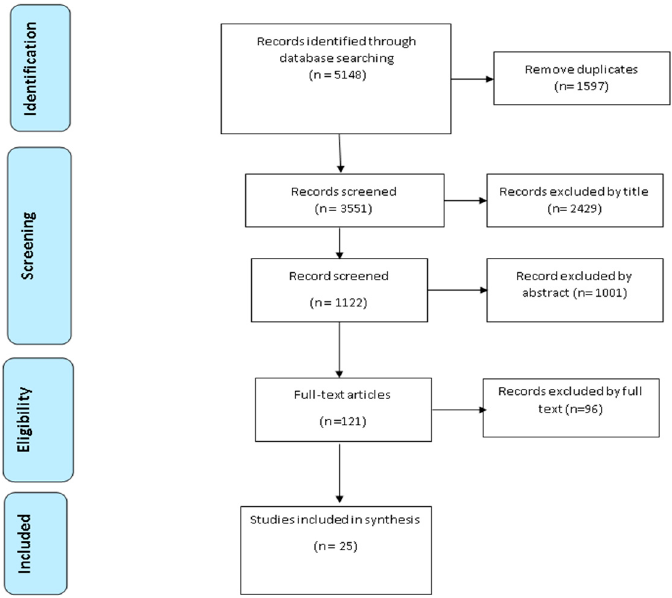
Figure 1. PRISMA flow chart of the systematic review.